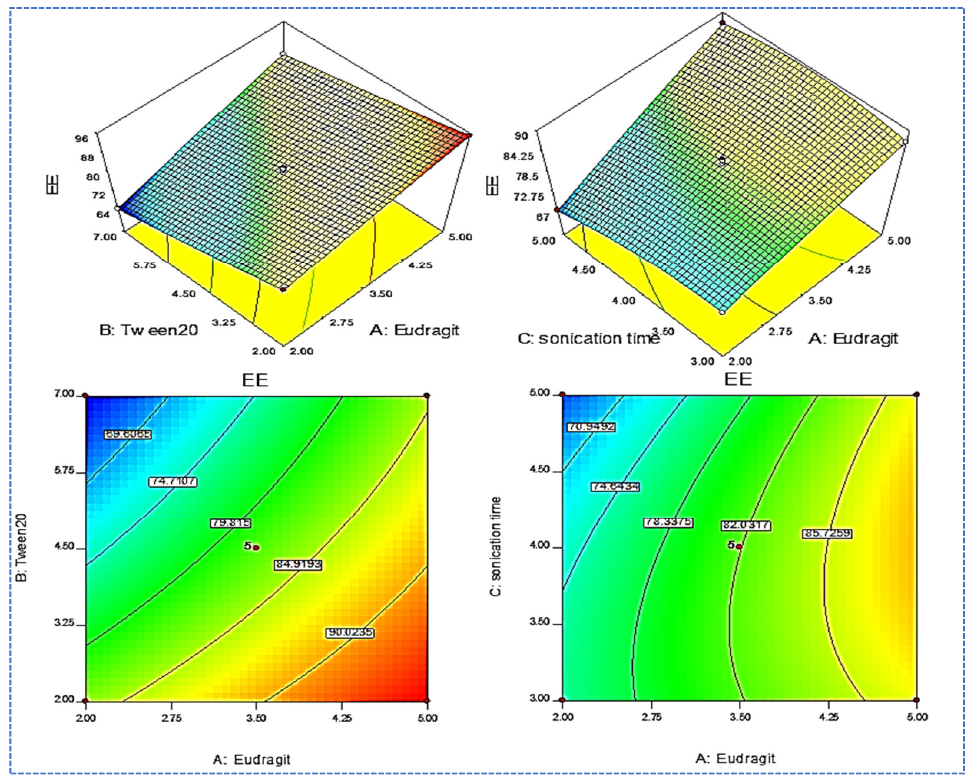
Figure 2. Response surface plot showing effect of Eudragit RSPO (A), Tween 20 (B), and sonication time (C) on the entrapment efficiency (Y 2 ). time (C) on the entrapment efficiency (Y 2